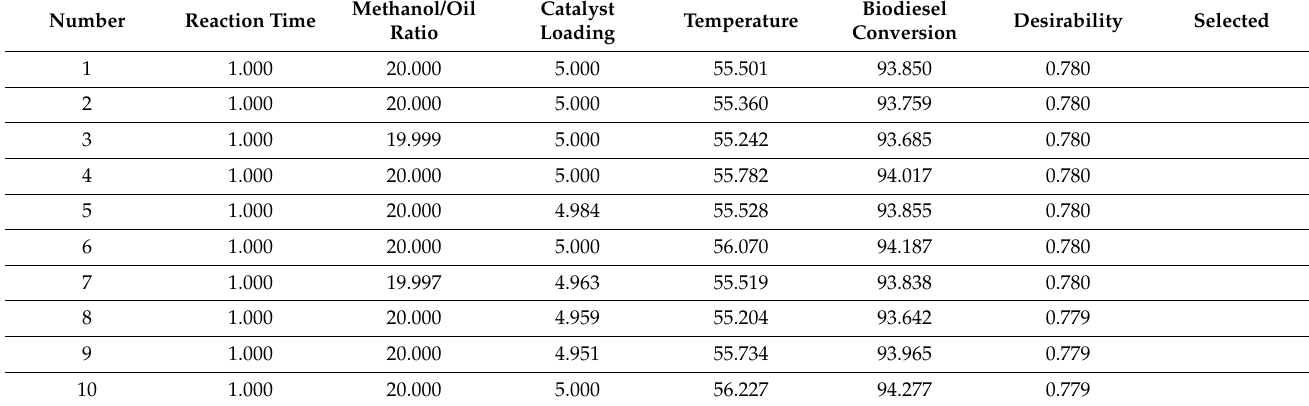
Table 8. Design expert’s obtained solutions.